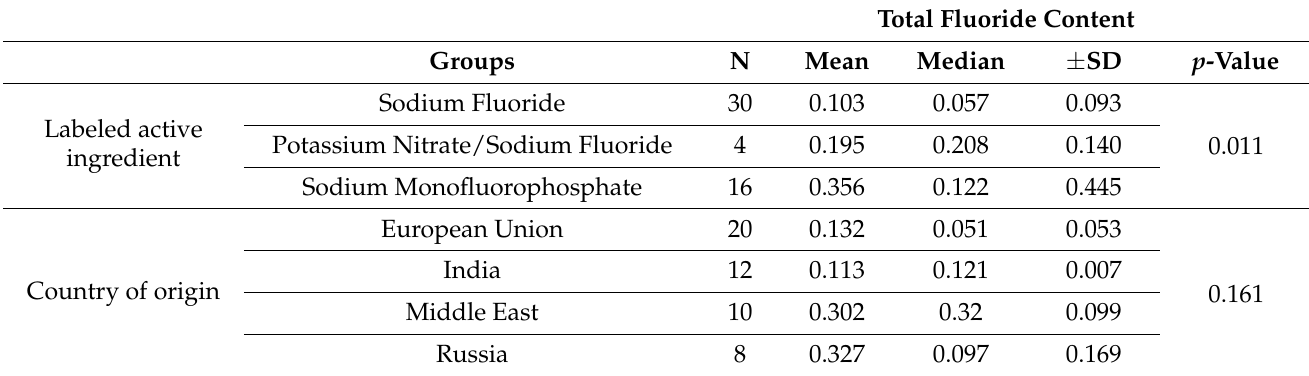
Table 4. Comparison of Total Fluoride Content According to Sample